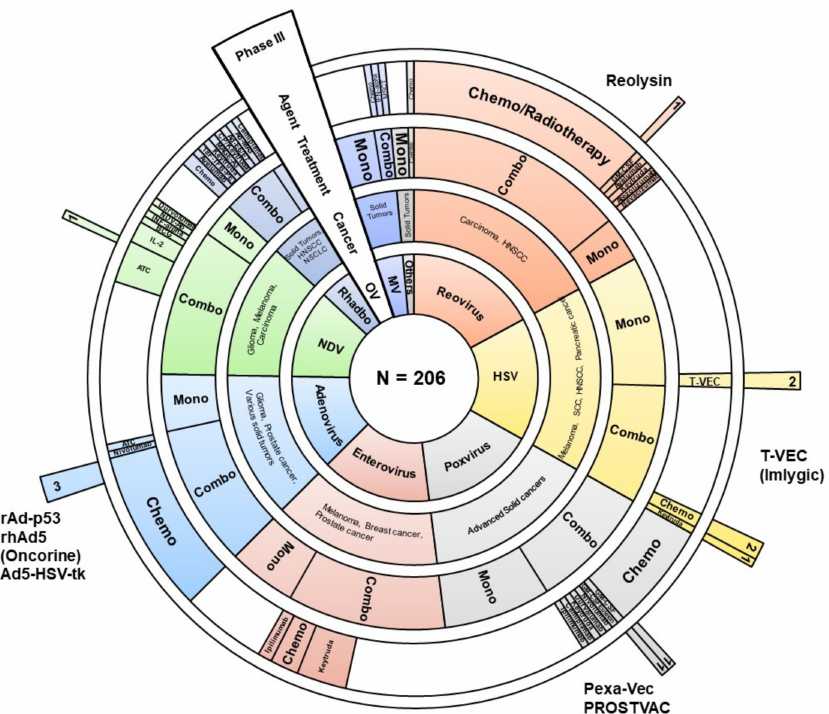
Figure 1. Graphical representation of 206 clinical trials using oncolytic viruses as an immunother- apy. Sunburst diagram depicts virus genus (inner circle), type of cancer, variants of therapy (single agent (mono) or combinatorial approach (combo), combinatorial agent (if applicable). Outer sec- tor illustrates the drugs that have reached Phase III of clinical trials or have been